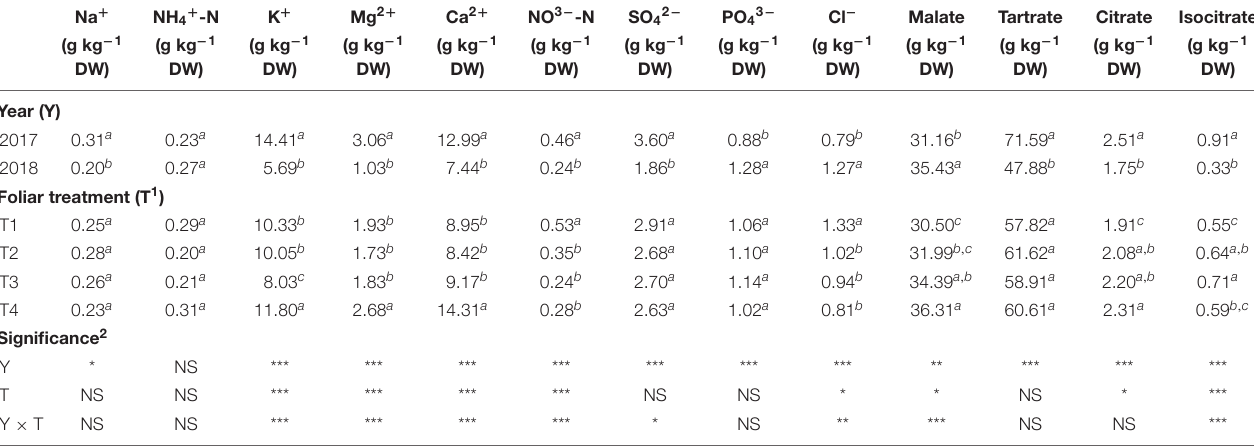
TABLE 5 | Main effects of year and foliar treatments on leaf mineral composition of V. vinifera “Aglianico” vines. Mean values and significance of interactions are shown. Different letters within column indicate significant differences according to Duncan’s multiple-range test ( P ≤ 0.05).